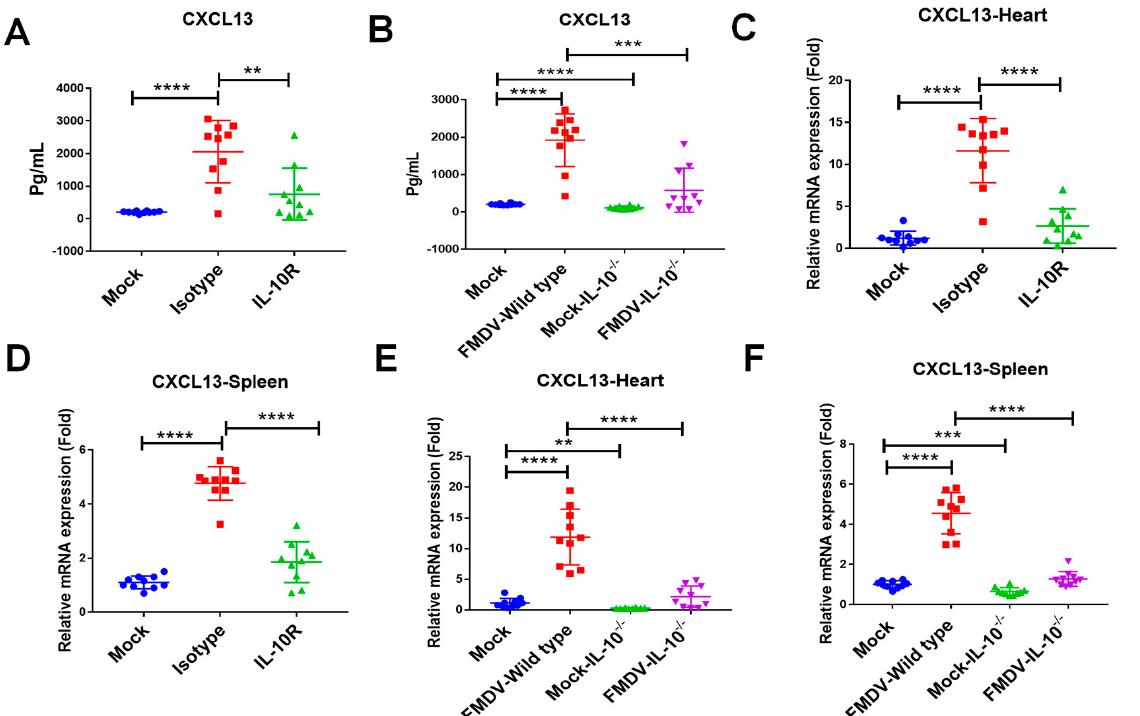
Figure 3. IL-10 mediated CXCL13 expression in FMDV-infected mice. ( A ) CXCL13 concentrations in sera from mock mice, infected mice with anti-IL-10R antibody, and infected mice with isotype antibody were measured by ELISA. ( B ) CXCL13 concentrations in sera from mock mice, wild-type mice infected with FMDV, IL-10 -/- mice, and IL-10 -/- mice infected with FMDV were measured by ELISA. The mRNA expressions of CXCL13 were detected in the heart ( C ) and spleen ( D ) of mock mice, infected-mice with anti-IL-10R antibody, and infected-mice with isotype antibody at 48 hpi. The mRNA expressions of CXCL13 were detected in the heart ( E ) and spleen ( F ) of mock mice, wild-type mice infected with FMDV, IL-10 -/- mice, and IL-10 -/- mice infected with FMDV at 48 hpi. Significance was detected using unpaired t test. **, p ≤ 0.01; ***, p ≤ 0.001; ****, p ≤ 0.0001.